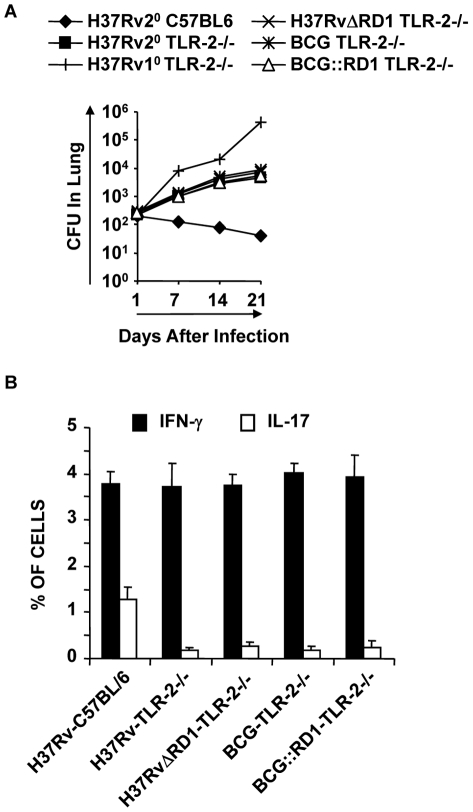
TLR-2-deficient animals induce reduced levels of protective immune responses.For in vivo experiments, wild type and TLR-2-/- mice were infected with H37Rv for 30 days, and subsequently treated with antibiotics for 4 weeks as described in the materials and methods. Mice were then re-challenged with H37Rv. Groups of animals were sacrificed for the following studies. (A) CFU in lung homogenates of mice re-challenged with H37Rv. (B) Intracellular cytokines in CD4+ T lymphocytes derived from the lung. Results presented here are representative of three independent experiments.